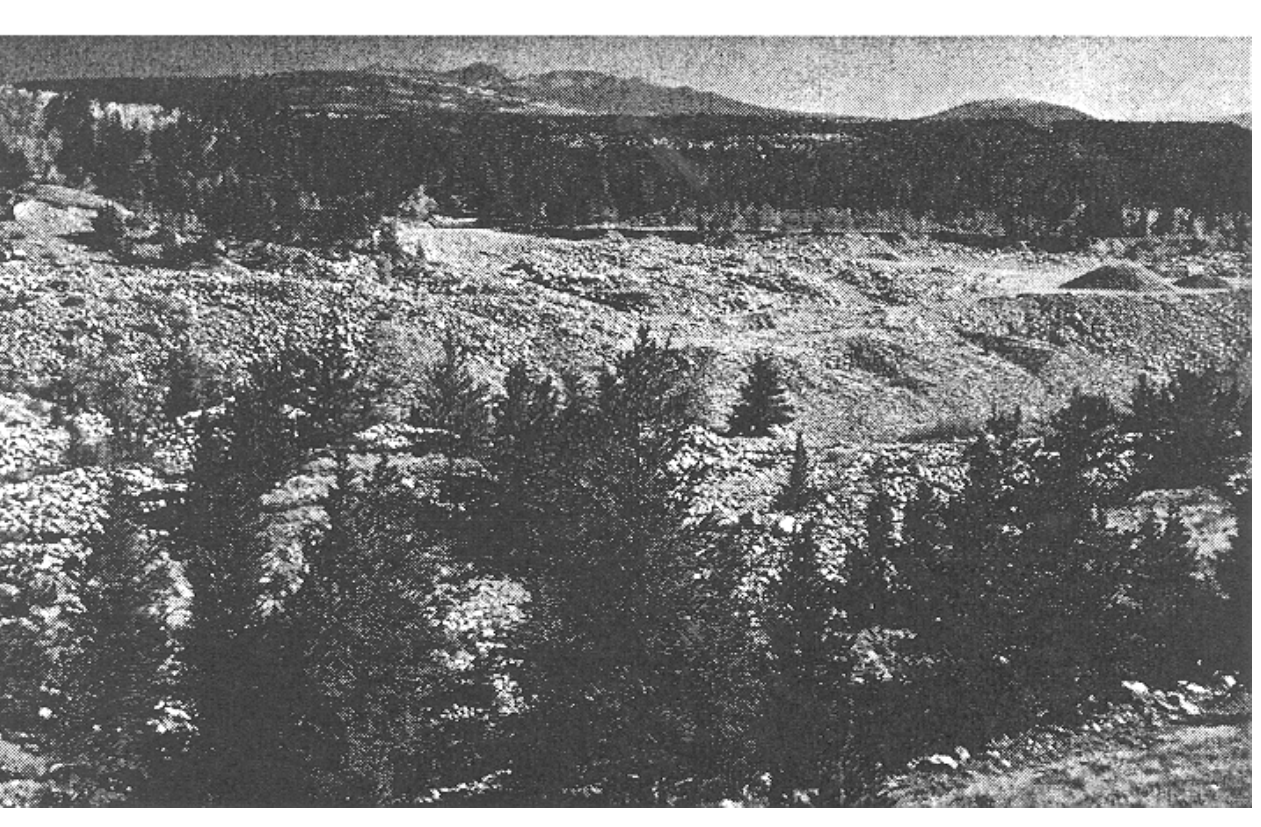
Fig. 4 . Dredge-boat